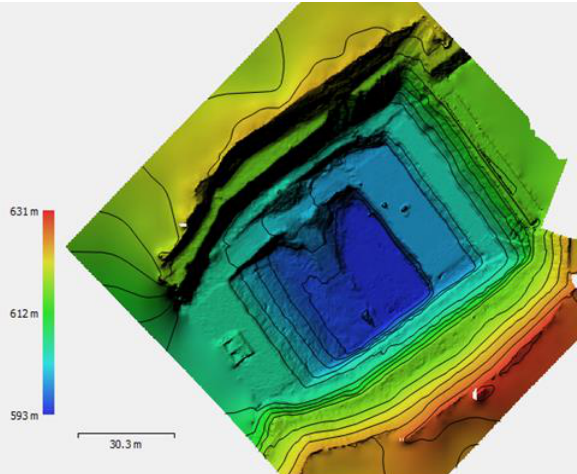
Figure 6.CRP Reconstructed digital elevation model with 2.5